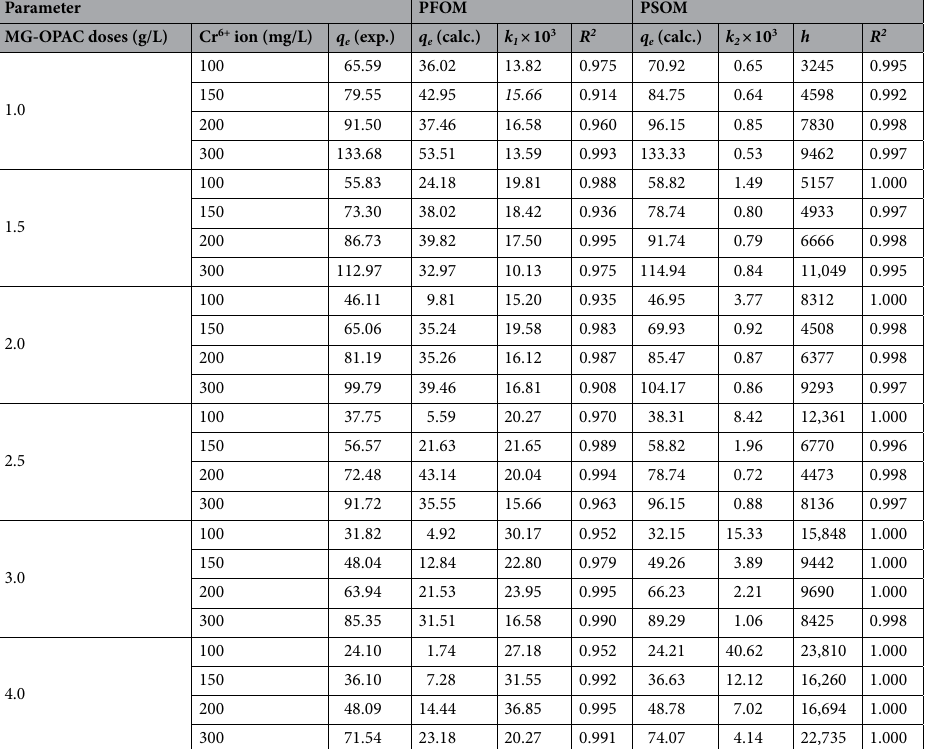
Table 3. Evaluation of the predicted and experimental q e data for various starting Cr 6+ ions and MG-OPAC doses, as well as the PFOM and PSOM adsorption rate